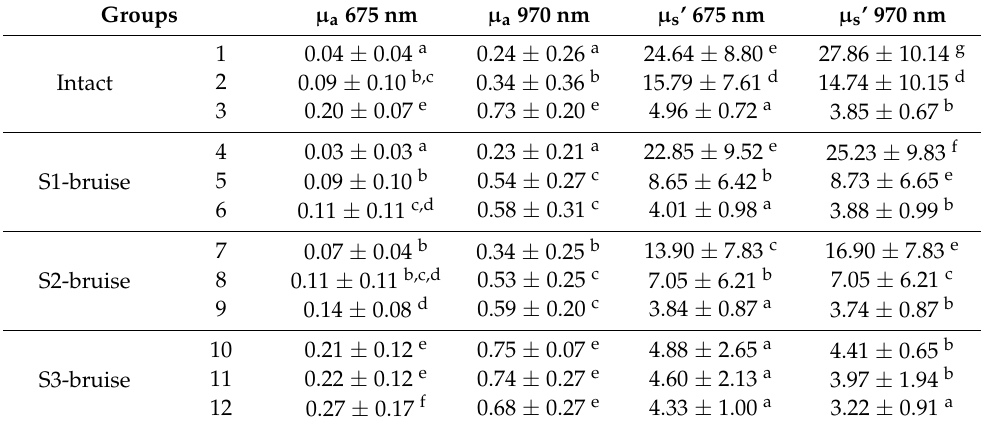
Table 3. Means and standard deviations of the optical parameters for different groups of peaches